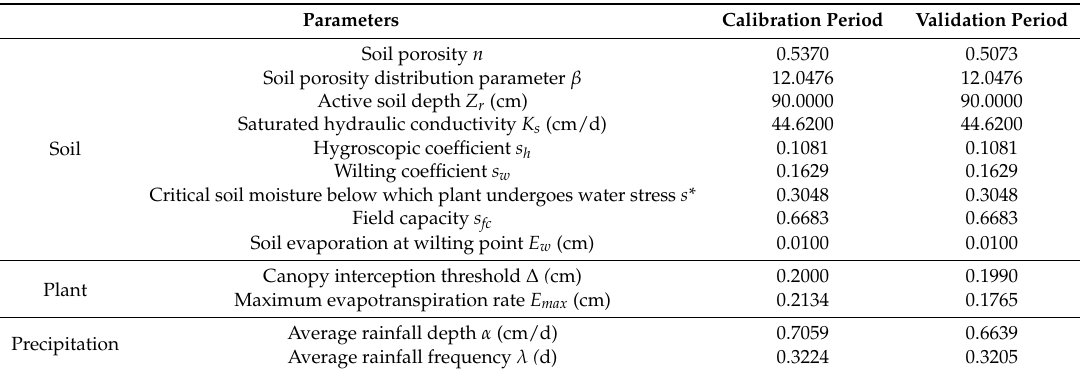
Table 6. Optimum model parameter values obtained by a genetic algorithm approach.